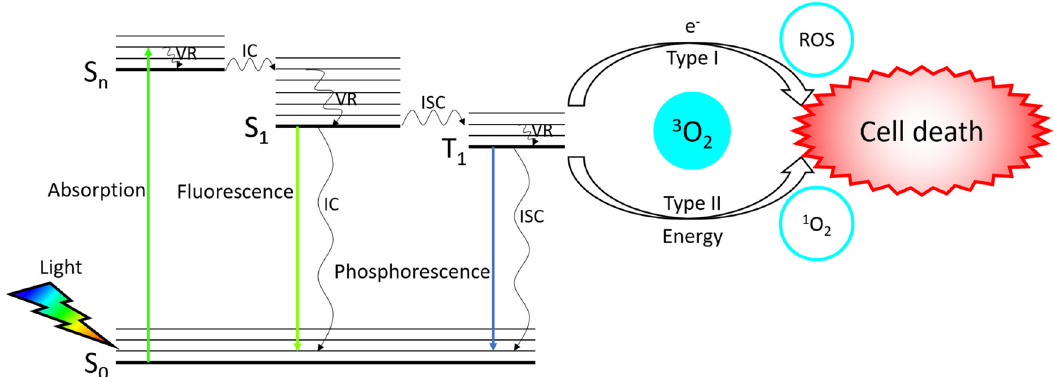
Figure 4: Extended Jablonski diagram showing the photophysical and photochemical processes relevant to PDT pathways. The PS in the ground state absorbs a photon and is promoted to an excited singlet state, S n , from which it undergoes nonradiative relaxations ( vibrational relaxations [ VR ] and internal conversion [ IC ]) to the lowest vibrational substrate of the lowest electronically excites singlet state. The molecule may undergo intersystem crossing ( ISC ) to the triplet state. The triplet state of PS can interact with oxygen by two mechanisms, named Type I and Type II.